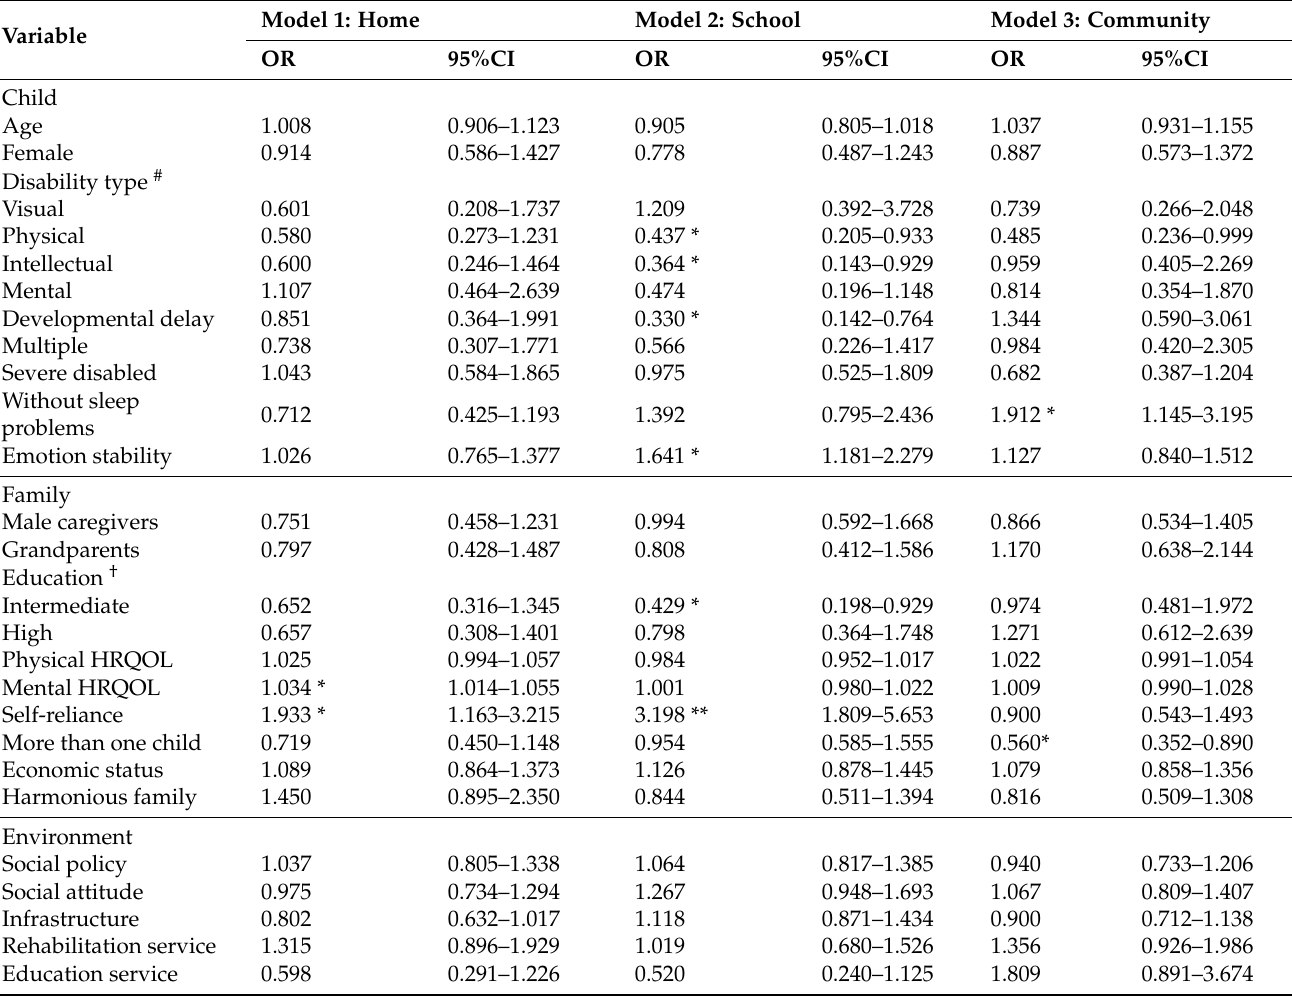
Table 4. Models 1–3 for factors associated with the home, school, and community participation of children with